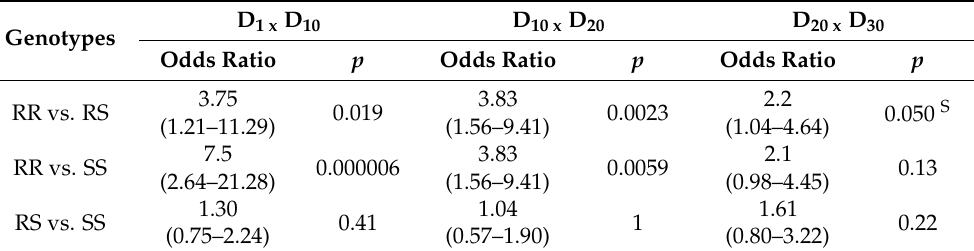
Table 3. Association between L119F-GSTe2 genotypes and adult longevity.